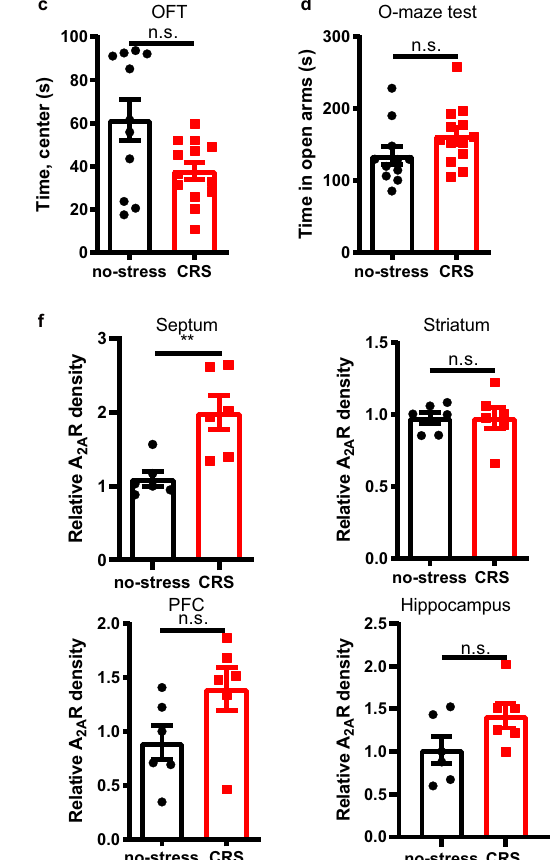
respectively, Unpaired t test, p =0.1165, t(22)=1.634) ( d ). e , f Representative